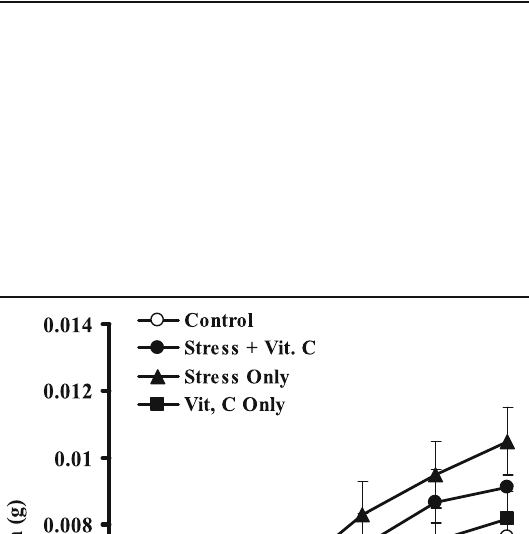
Fig. 1 Graphical representation showing the effect of chronic variable stress with vitamin C supplementation on contractile activity of testicular artery strip to doses of phenylephrine